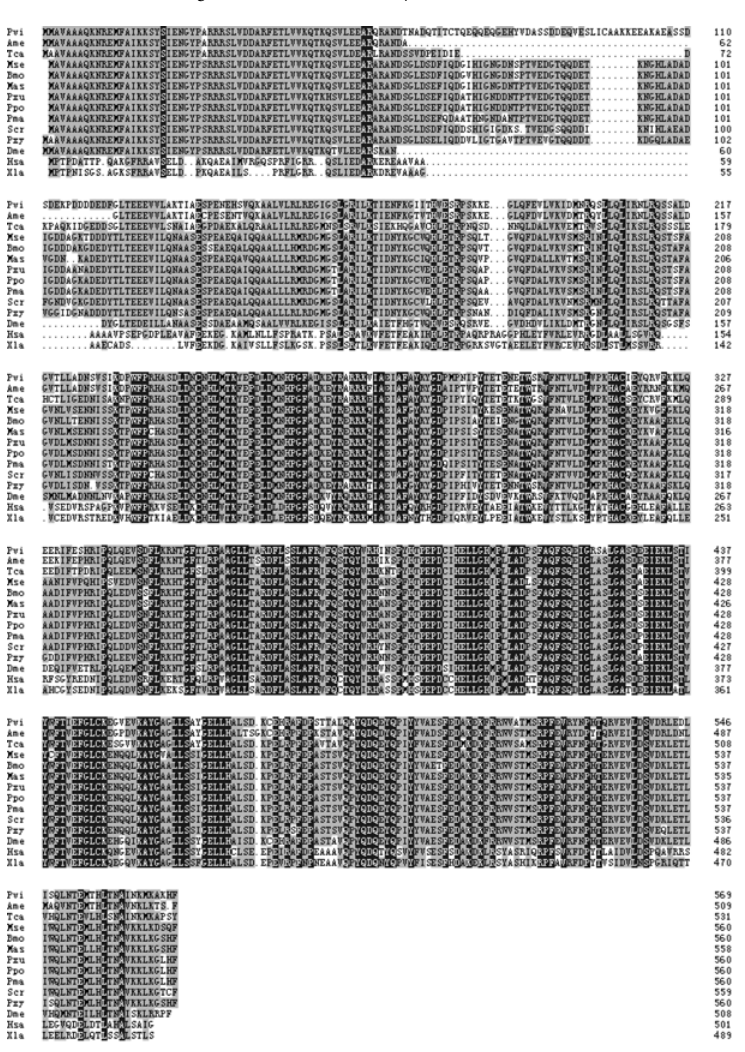
Fig.5. Amino acid sequence alignments of PvtH ( Polyrhachis vicinna (Pvi)) with other species: Apis mellifera (Ame) NP_001011633; Tribolium castaneum (tca) NP_001092299; Mythimna separata (Mse) bAF32573; Bombyx mori (bmo) NP_001138794; Manduca sexta (Mas) AbQ95973; Papilio xuthus (Pxu) bAE43824; Papilio polytes (Ppo) bAJ07593; Papilio machaon (Pma) bAJ07587; Samia cynthia ricini (scr) bAF64534; Plutella xylostella (Pxy) ADK12633; Drosophila melanogaster (Dme) NP_476897; Homo sapiens (Hsa) AAI43615; Xenopus laevis (Xla) NP_001091392. conserved amino acids in all tHs are shown in black and residues that are similar with respect to side chains in gray; gaps are introduced to optimize the